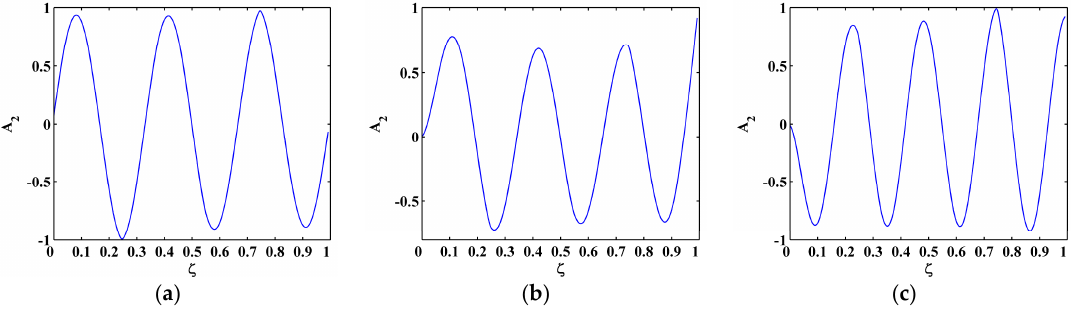
Figure 6. The second-level approximations of the ( a ) sixth; ( b ) seventh; and ( c ) eighth mode shapes with 60 dB SNR. Materials 2017 , 10 , 656